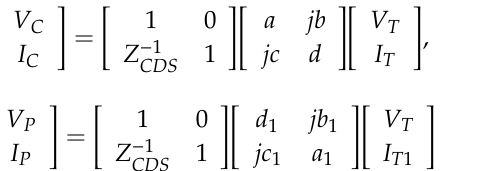
Figure 2. The proposed DPA topology.